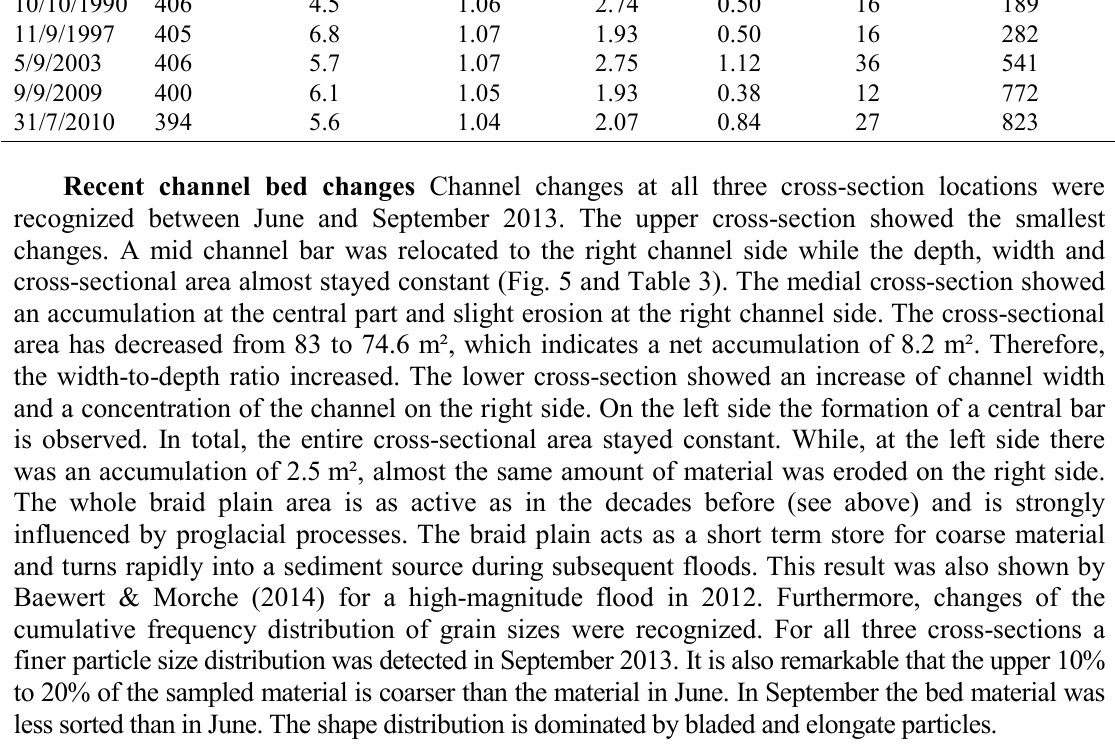
Table 3 Characteristic channel cross section parameters and grain sizes. Cross-